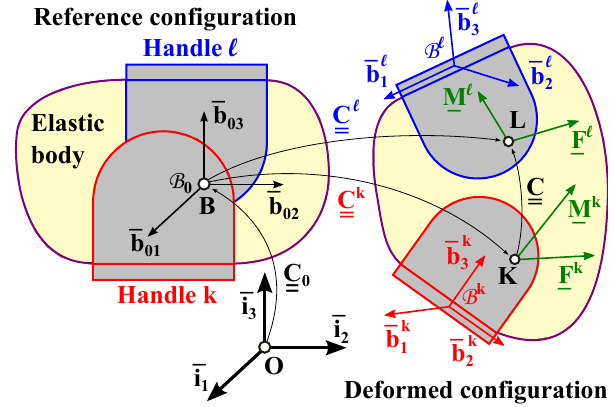
Figure 1. Configuration of the flexible